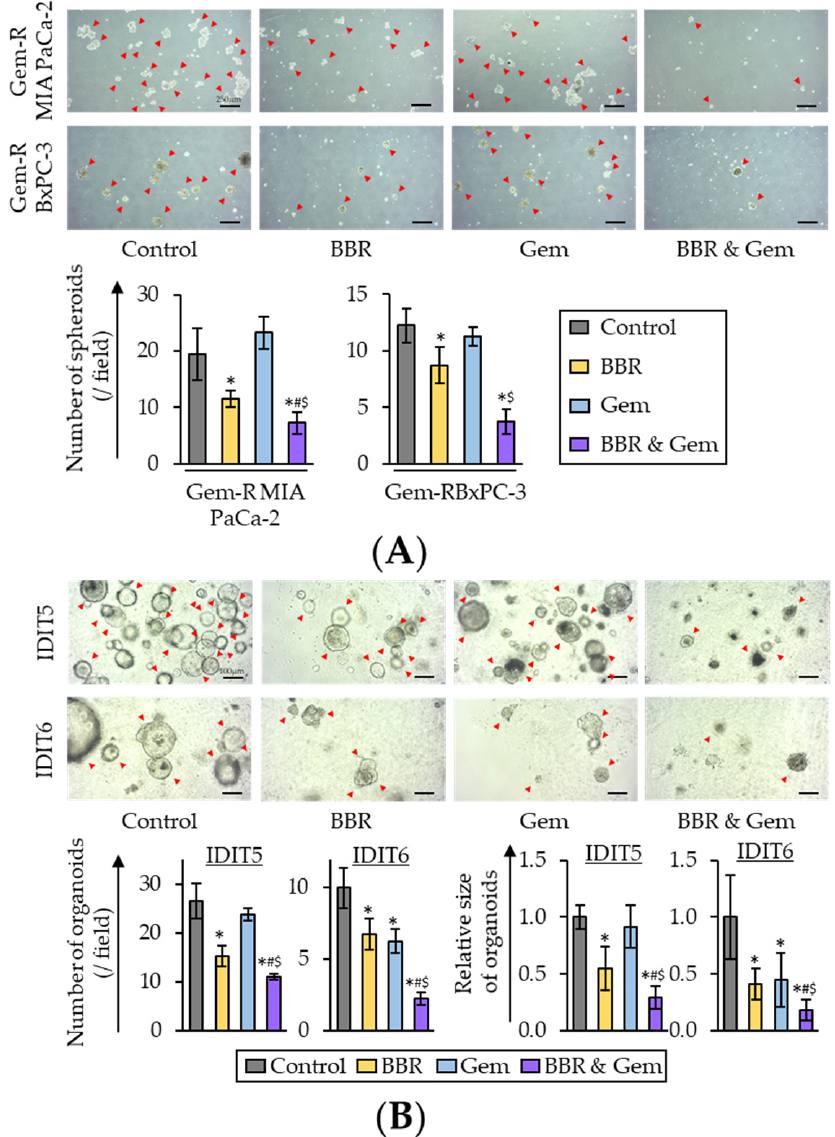
Figure 6. The combination of Berberine and Gemcitabine suppressed spheroid formation and growth of human PDAC tumor-derived organoids. ( A ) Representative images of sphere forming Gem-R PDAC cells following treatment. Scale bar = 250 µ m (Magnification × 40). The average (column) ± SD is indicated (* p < 0.05 vs. control, # p < 0.05 vs. BBR, $ p < 0.05 vs. Gem). ( B ) Representative images of tumor organoids following treatment. Scale bar = 100 µ m (Magnification × 100). The average (column) ± SD is indicated (* p < 0.05 vs. control, # p < 0.05 vs. BBR, $ p < 0.05 vs. Gem). Gem-R, Gemcitabine-resistant; PDAC, pancreatic ductal adenocarcinoma; BBR, Berberine; Gem, Gemcitabine; SD, standard deviation.